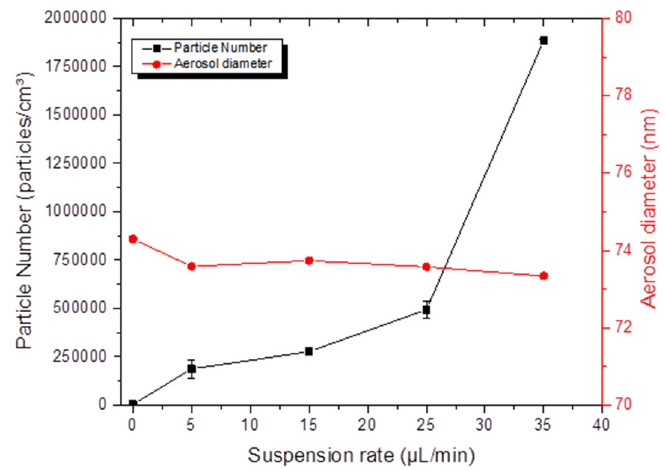
Figure 7. Parameters influencing electrospray aerosol generation: average diameter and number of particles of TiO2 (20 nm) in the aerosols as function of the NP suspension flow rate.